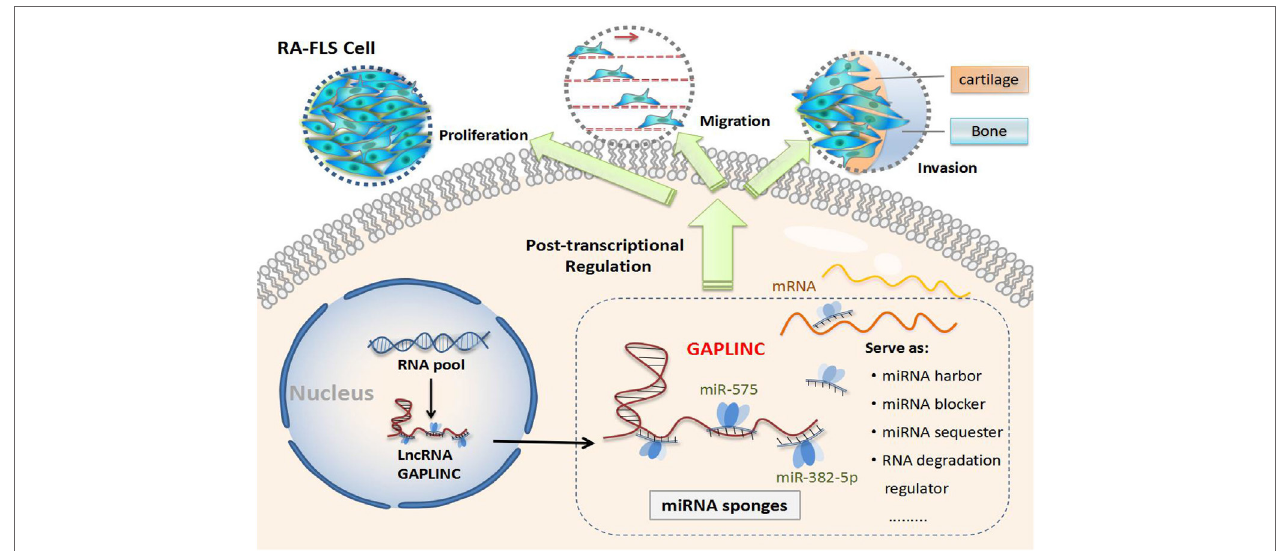
FigUre 6 | The schematic representation showing possible mechanism of LncRNA GAPLINC. The high expression level of GAPLINC may regular cell behaviors in rheumatoid arthritis (RA)-fibroblast-like synoviocytes (FLSs) though a post-transcriptional way. Bioinformatics analysis speculated that GAPLINC may be molecular attractions for microRNAs and have some regulatory roles. In this investigation, the expression of miR-382-5p and miR-575 had significant increases after GAPLINC suppression, suggesting GAPLINC may promote RA-FLS tumor-like behaviors in an miR-382-5p-dependent and miR-575-dependent